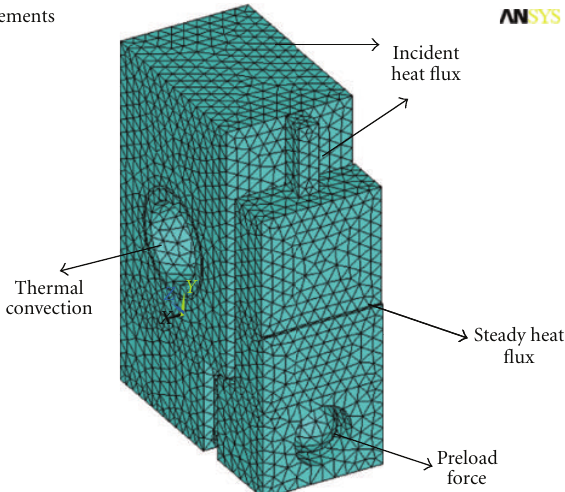
Figure 3: The finite element model and thermal loads.